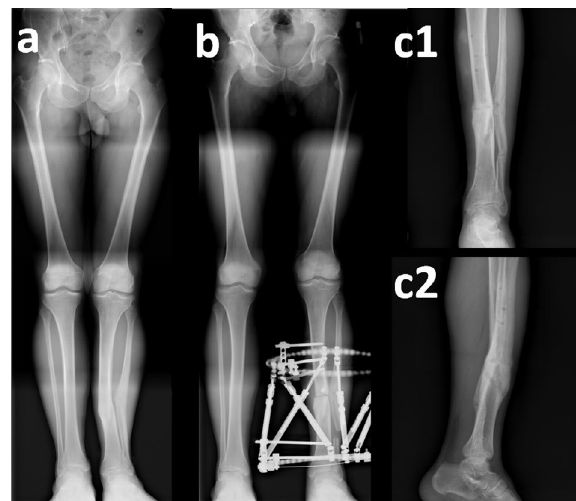
Figure 6. Case No. 17 in Table 1. (a) Valgus, procurvatum and rotation deformity of tibia, (b) after correction with Spider Frame, (c1) and (c2) anteroposterior and lateral X-rays of same patient after removal of Spider Frame.